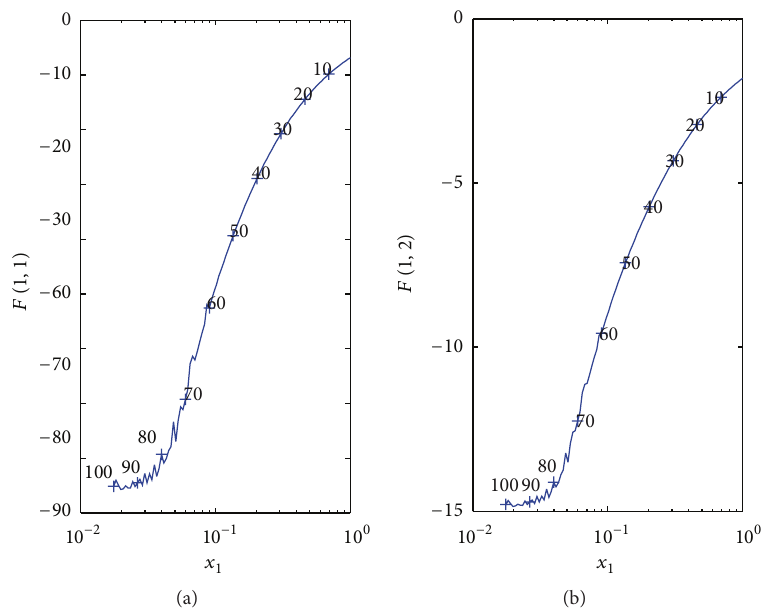
Figure 4: The offline control law F for Example 12.